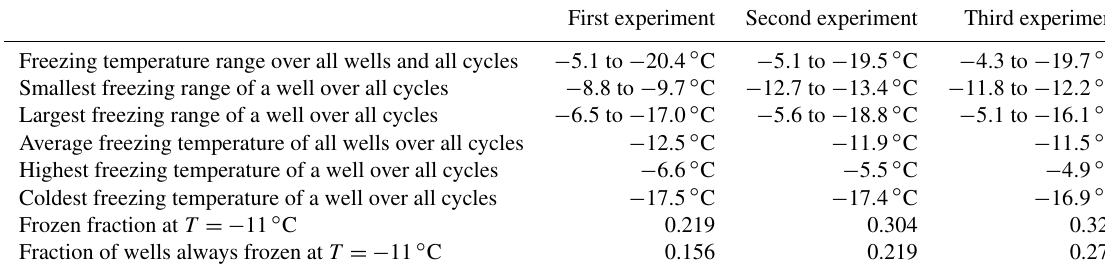
First experiment Second